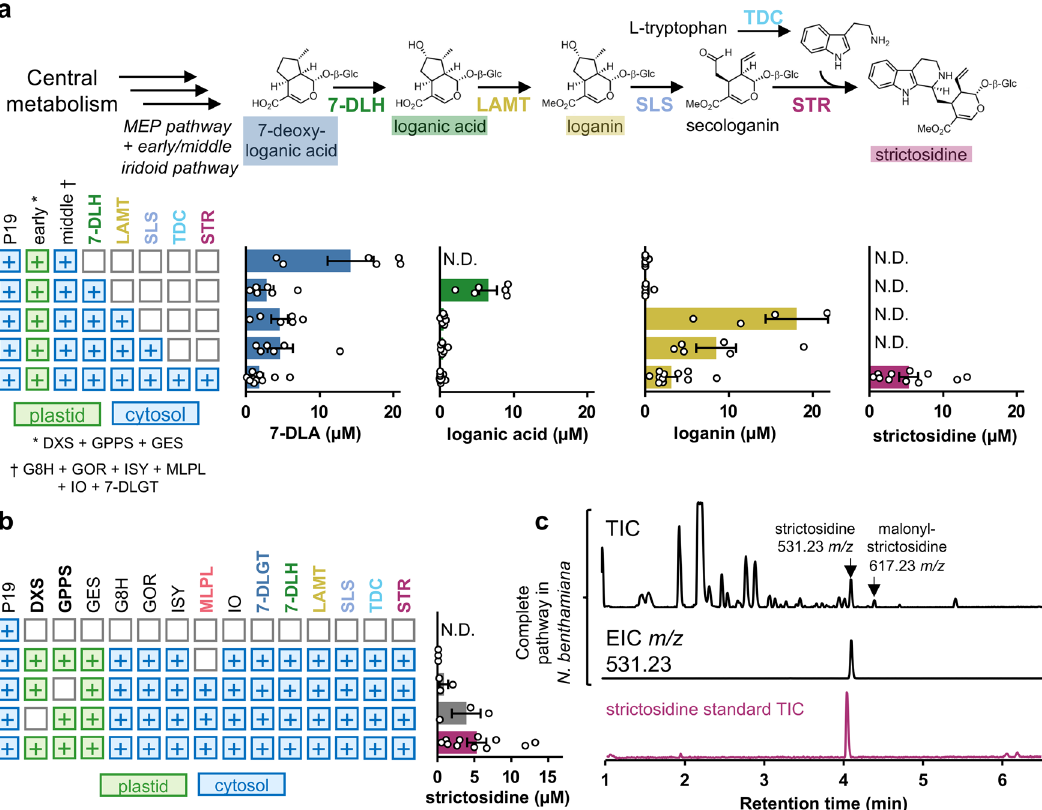
Fig. 5 Reconstitution of strictosidine biosynthesis in N. benthamiana . a Quanti fi cation of intermediates and fi nal product strictosidine by UPLC/MS analysis. b Absence of MLPL reduces strictosidine production >60 fold while supplementation of GPPS improves yield ~5 fold. c the total ion chromatogram of leaf tissue in fi ltrated with the entire pathway to strictosidine (including DXS, GPPS, and MLPL). The peak at 4.09 min retention time in the total ion chromatogram (TIC) and extracted ion chromatogram (EIC) at 531.2336 m/z matches a strictosidine standard. N.D., not detected; 7-DLH, 7-deoxyloganic acid hydroxylase; LAMT, loganic acid O-methyltransferase; SLS, secologanin synthase; TDC, tryptophan decarboxylase; STR, strictosidine synthase. Values and error bars represent the mean and the standard error of n = 3 or n = 6 biological replicates (independent leaf samples).